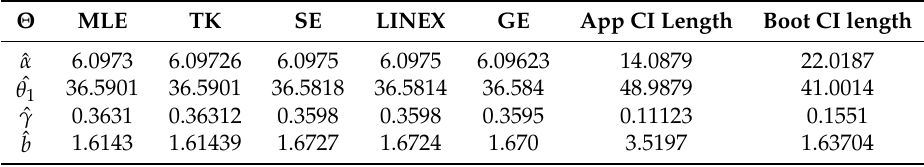
Table 3. Maximum likelihood estimates (MLEs), Tierney and Kadane (TK) estimates, importance sampling Bayes estimates (BEs) under square error (SE), linear exponential (LINEX), and general entropy (GE) loss functions, and length of 95%